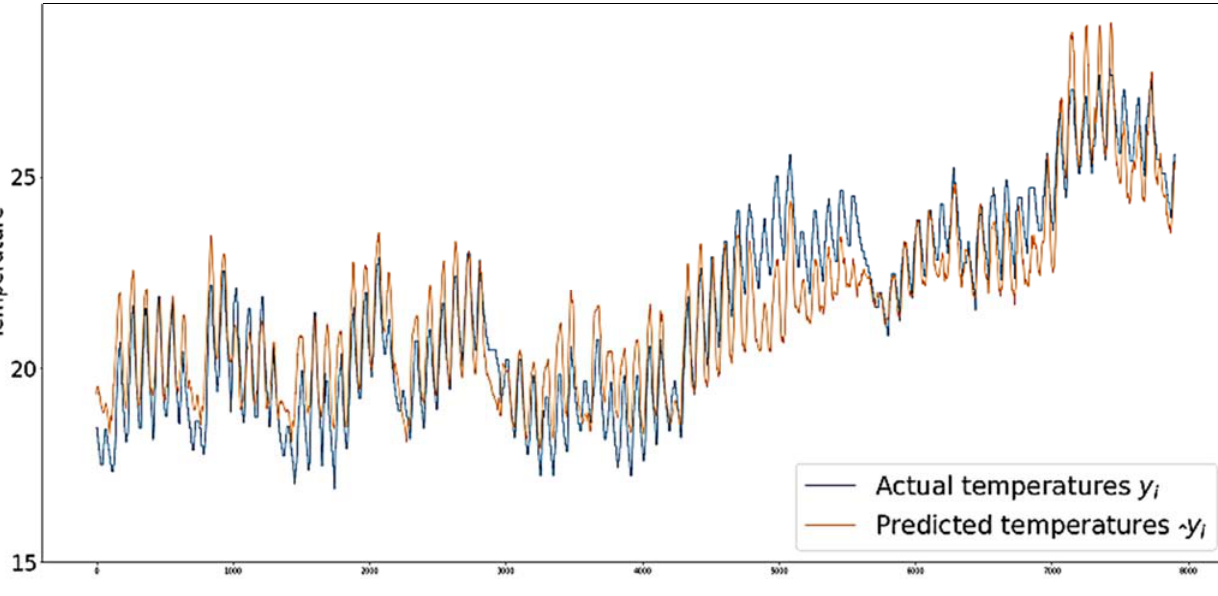
Figure 20. Plot of actual and predicted temperatures 5 h ahead for office 40 on the third floor.